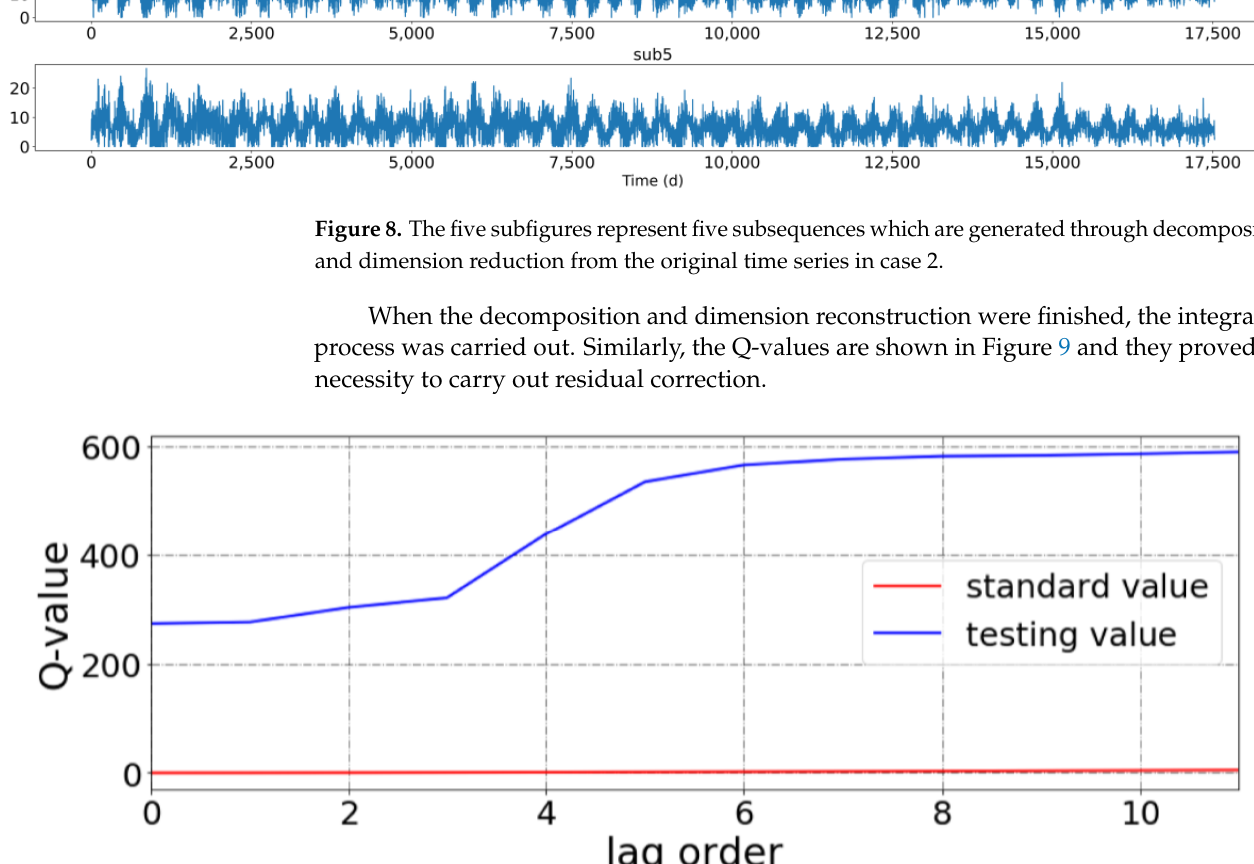
The integration process and the residual comparison are shown in Figure 10.